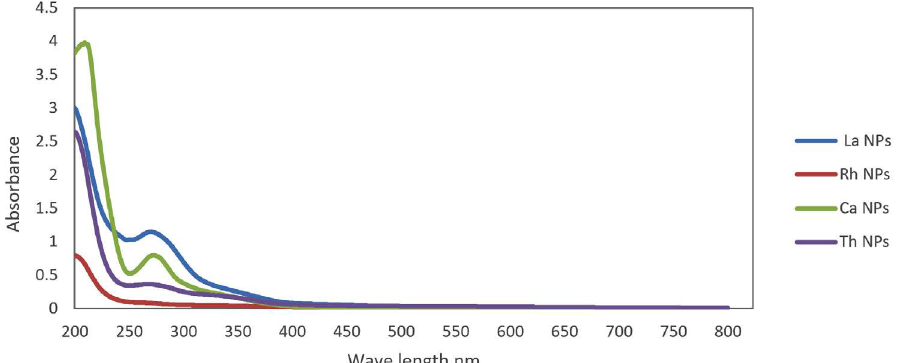
Fig. 3. UV-Vis absorbance of La, Rh, Ca and Th silver nanoparticles.